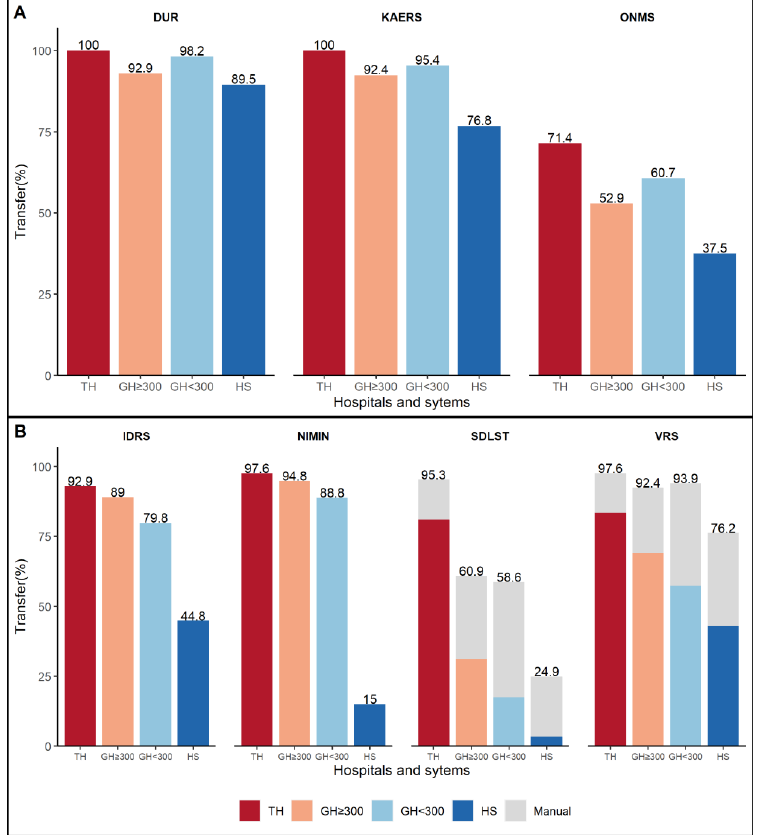
Figure 3. Systems for transferring clinical data to the government surveillance system ( A , B ). Ab- breviations: TH, tertiary hospital; GH ≥ 300, general hospital with more than 300 beds; GH < 300, general hospital with less than 300 beds; HS, hospital; DUR, drug utilization review; KAERS, Korean Adverse Event Reporting System; ONMS, Opioid and Narcotics Use Management System; IDRS, Infectious Disease Report Support Program; NIMIN, National Emergency Medicine Information Net- work; SDLST, Life-Sustaining Medical Information Processing System; VRS, Vaccination Registration Management